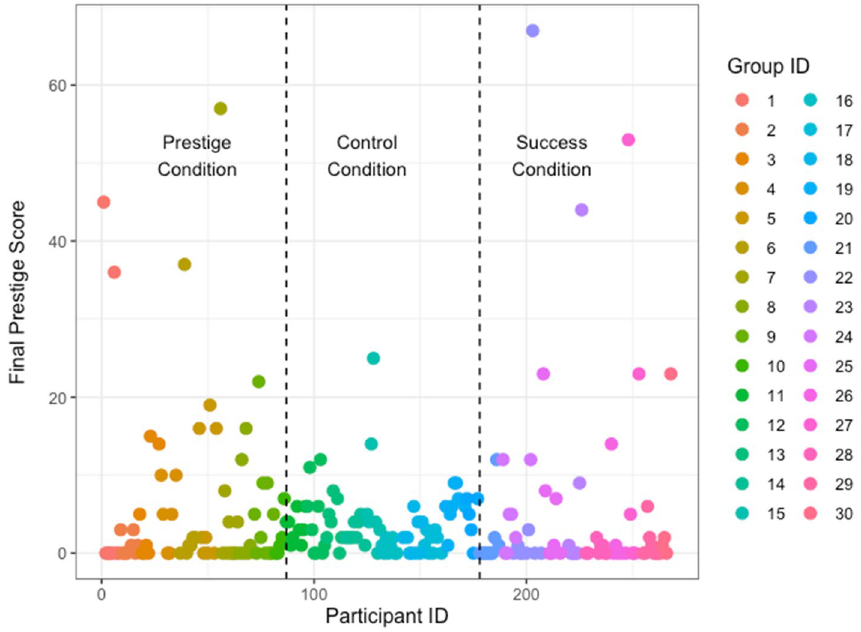
Figure 4. The total number of times each participant was copied (i.e. their ‘prestige’) across all conditions, clustered by group as indicated by different colours. The dashed lines demarcate the experimental conditions, Prestige, Control and Success from left to right. Groups 1–10 were in the Prestige Condition, 11–20 were in the Control, and 21–30 were in the Success Condition. The majority of participants were never copied, or were copied under 10 times. A minority of participants were copied 20–40 times, and just 5 participants were copied over 40